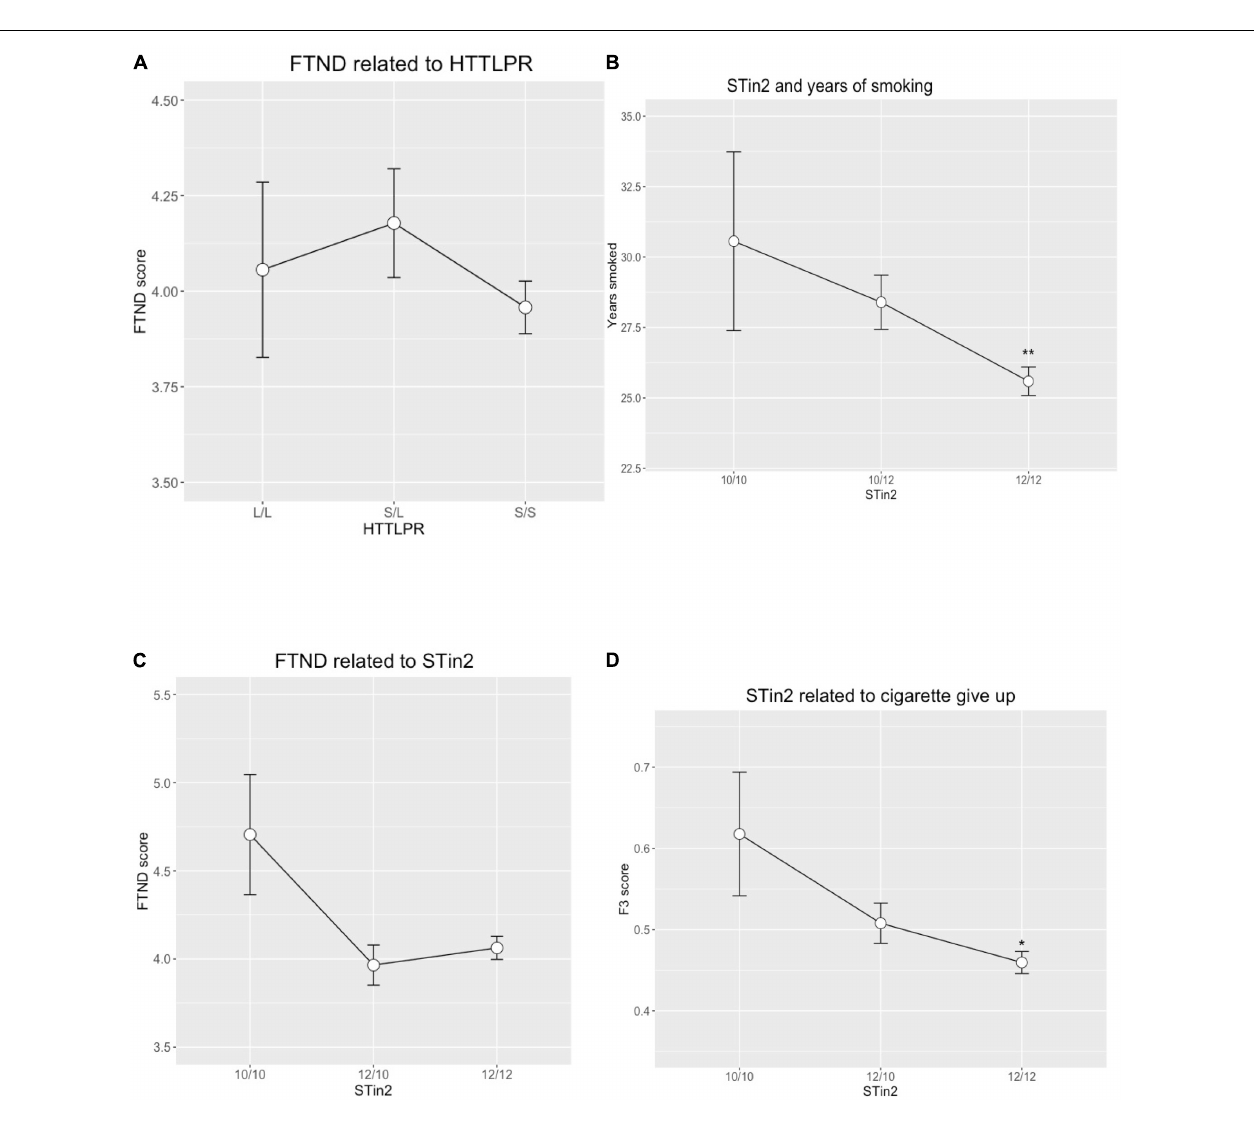
FIGURE 1 | (A) FTND scores related to the genotypes of HTTLPR. (B) Years of smoking are associated with the genotypes of STin2. (C) Interrelations between FTND scores and STin2 genotypes. (D) STin2 genotypes are associated with difficulties in giving up the first cigarette a day. ∗ p < 0 . 05; ∗∗ p < 0 . 01.